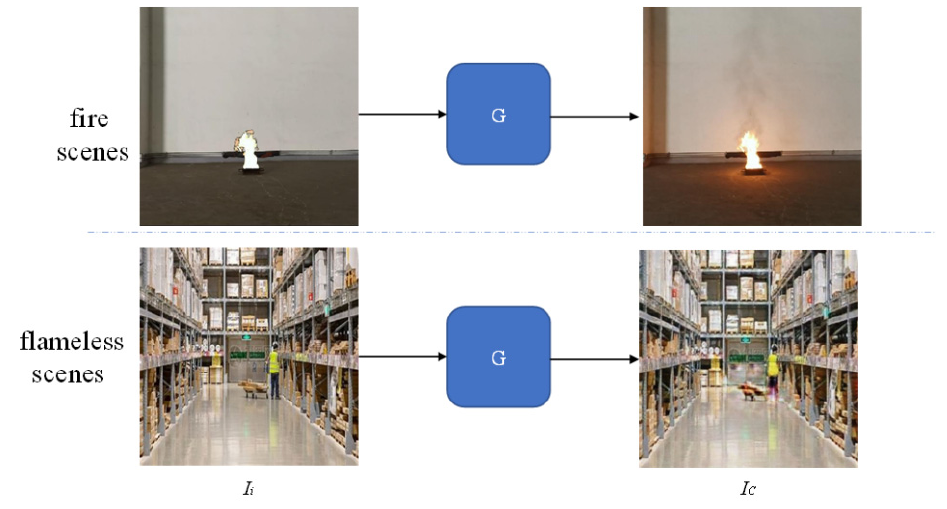
Figure 4. Data augmentation.